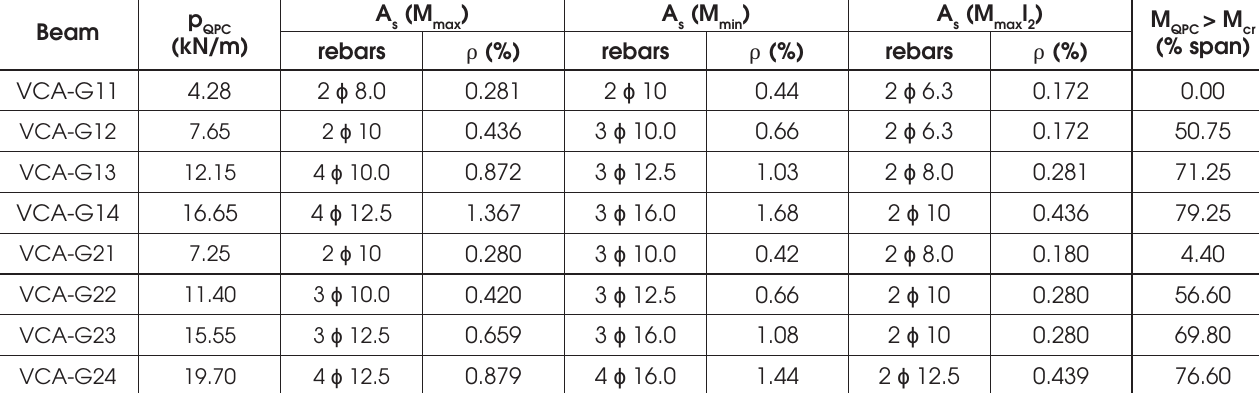
Comparison between simplified and FE models for short-term deflection in continuous RC beams